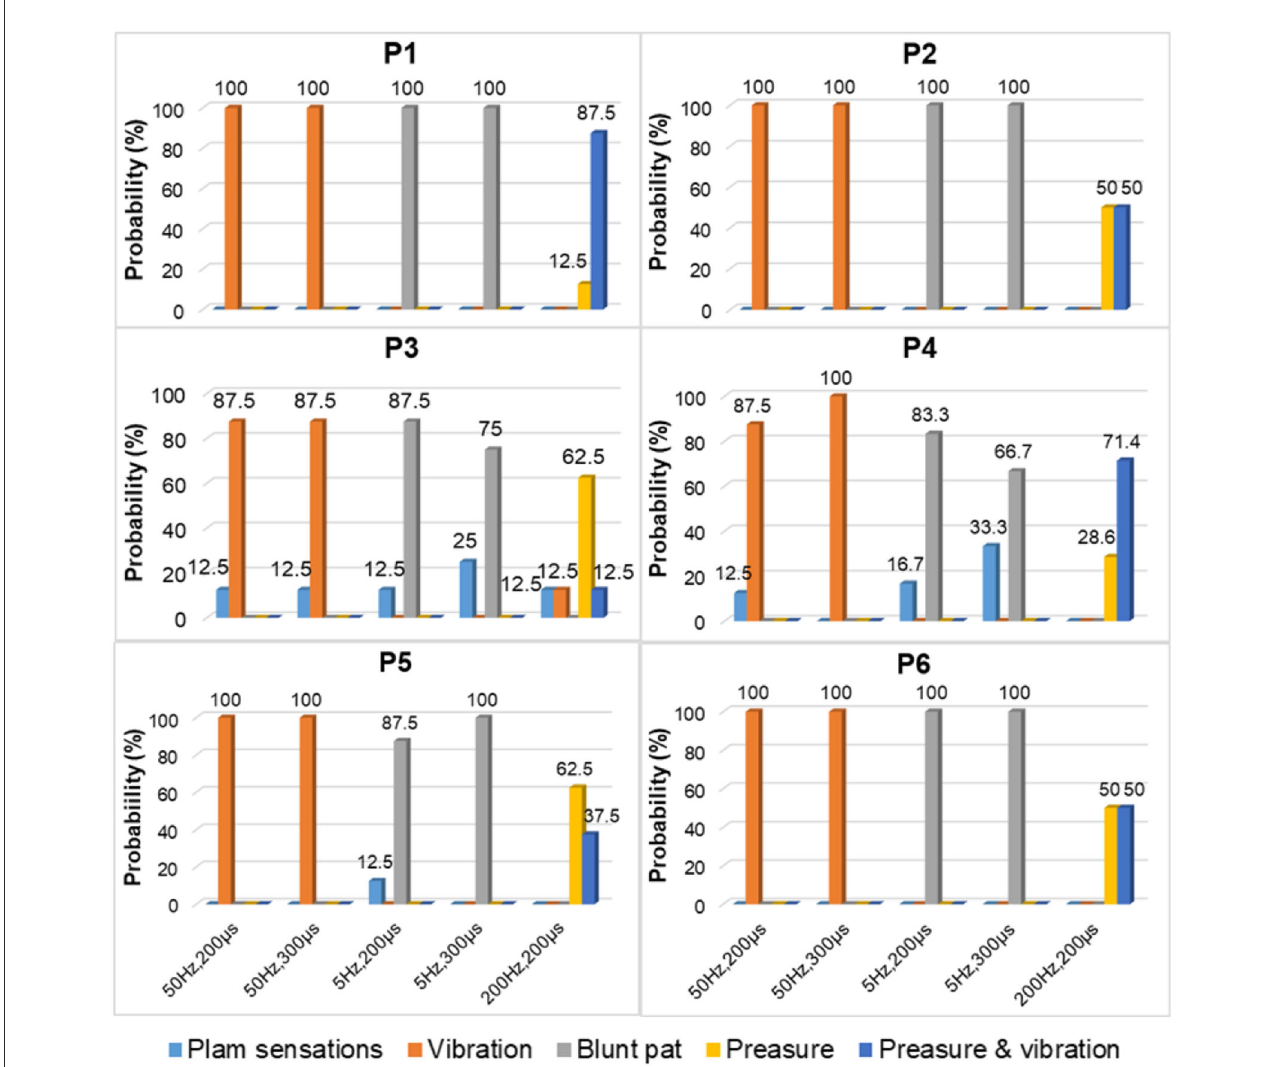
FIGURE10 The TENS parameters and the types of evoked sensations on the six positions under the MS